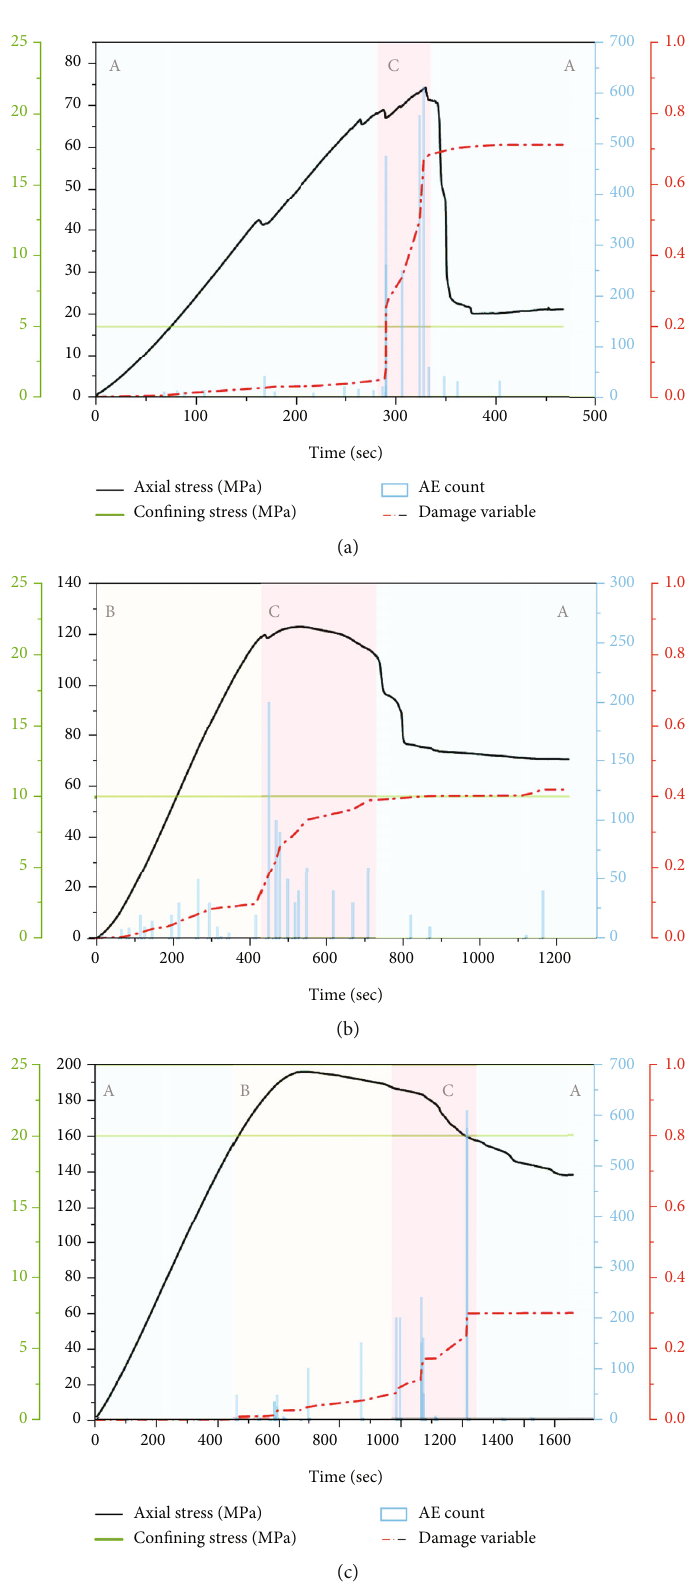
Figure 6: AE ringing count/damage variable-time relations of Scheme 1 under di ff erent con fi ning pressures (con fi ning pressure setting: (a) 5MPa, (b) 10MPa, and (c)